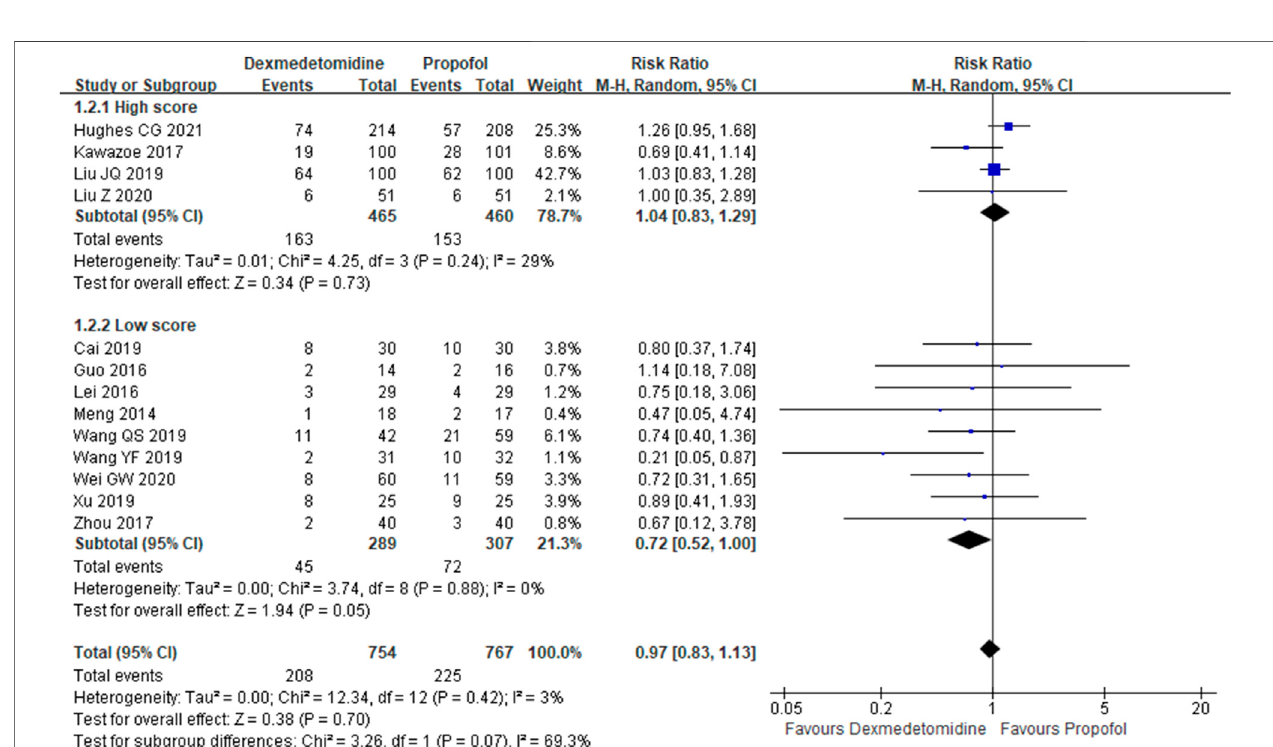
FIGURE 3 | Forest plot of ICU stays.